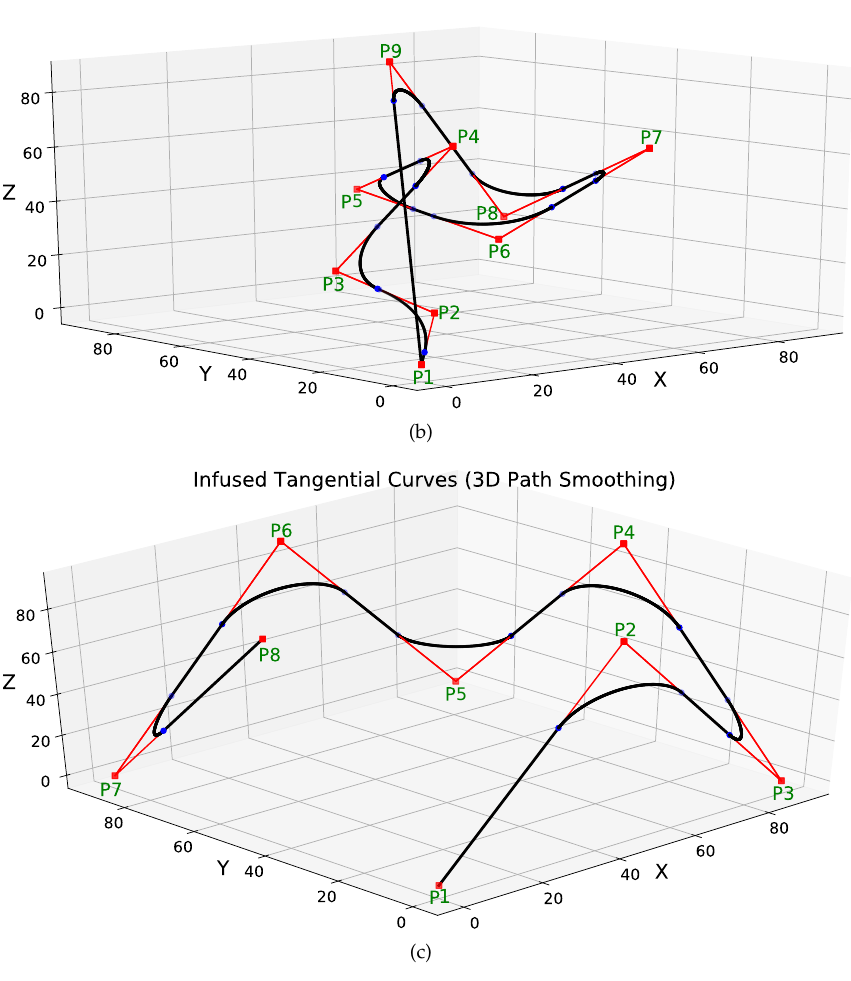
Figure 10. 3D path smoothing. ( a ) closed loop 3D path smoothing; ( b ) a complex closed loop 3D path smoothing case; ( c ) an open loop 3D path smoothing